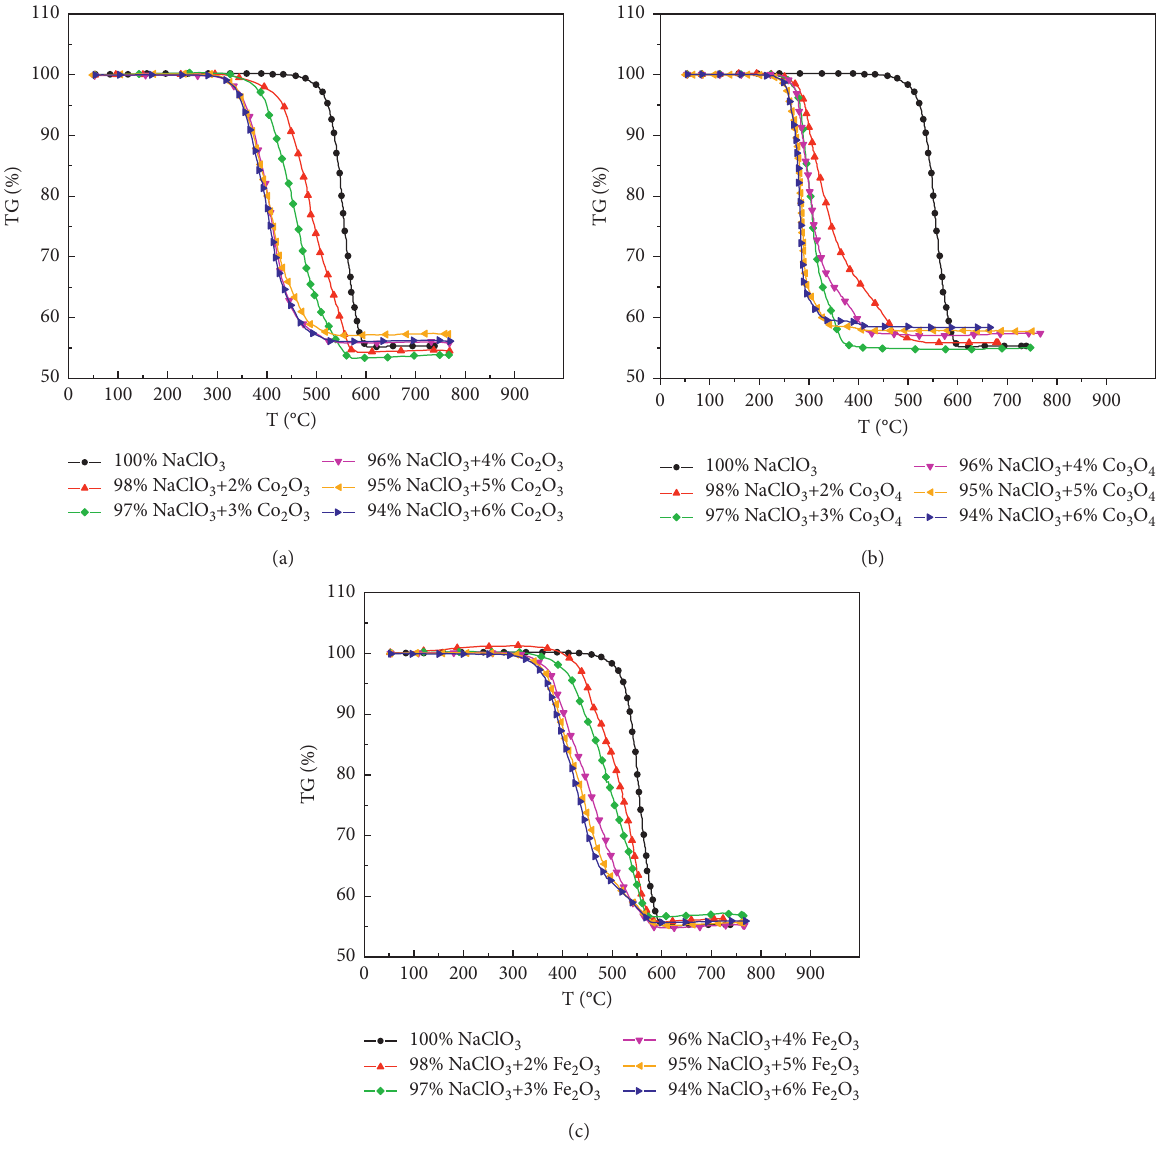
Figure 5: NaClO 3 oxide TG curve. (a) NaClO 3 –Co 2 O 3 TG curve. (b) NaClO 3 –Co 3 O 4 TG curve. (c) NaClO 3 –Fe2O 3 TG (Figure 8) and the oxygen candle O concentration curve 2 (Figure 9). The experiment was carried out for 53 min, and the entire oxygen supply reaction was divided into four stages: the initial reaction stage (0–6 min), rapid rise stage (6–13 min), rapid decline stage (13–17 min), and stable end- stage (17–53 min). In the initial reaction stage, the oxygen production rate in the reaction space was 0 L/min, and the oxygen concentration was maintained at 20%. This shows that the oxygen candle reacted slowly in the initial stage, and the gas monitoring system did not detect the generation of oxygen, and thus, the oxygen concentration in the reaction oxygen production rate in the experimental space increased